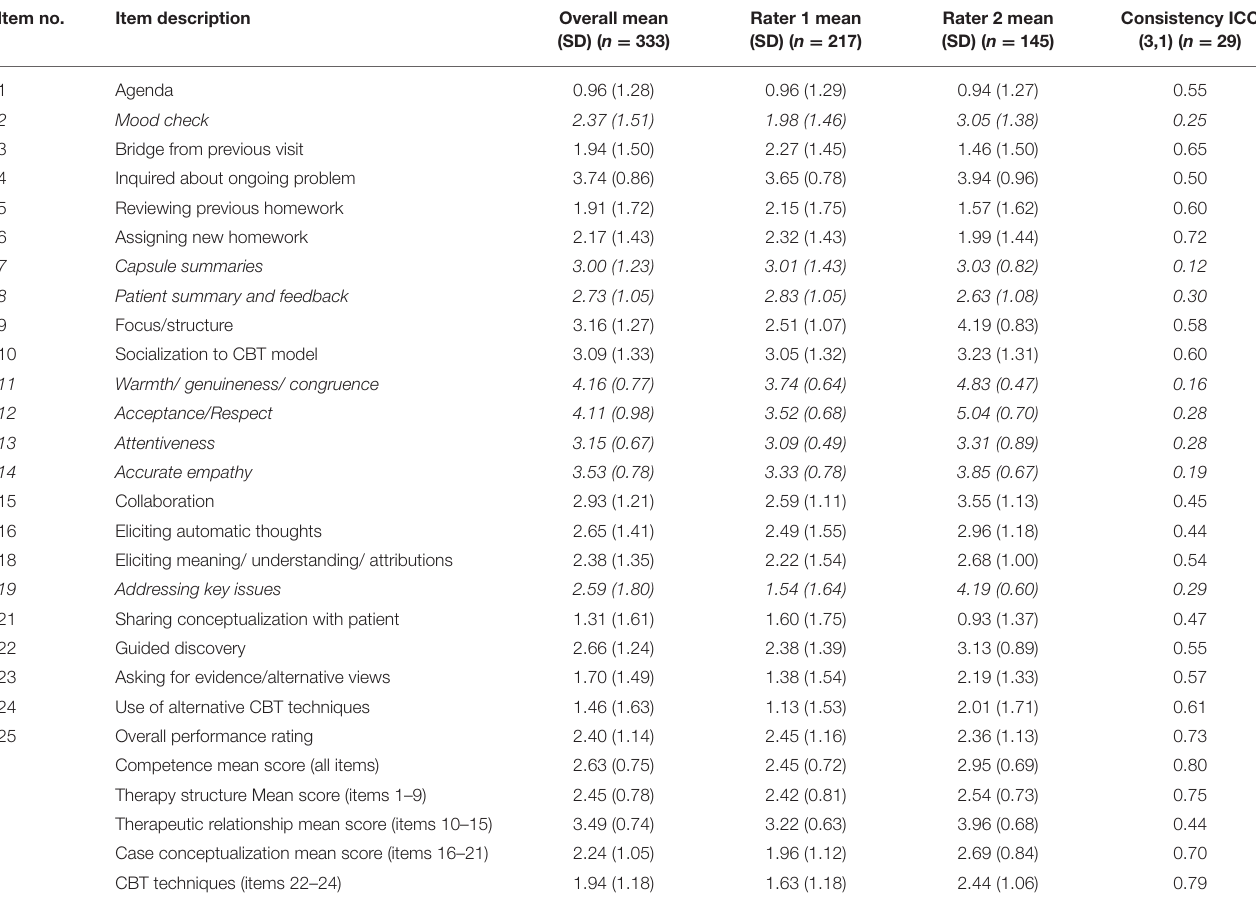
TABLE 1 | Means, SD and ICC reliability coefficients for the competence items of CTACS. Item